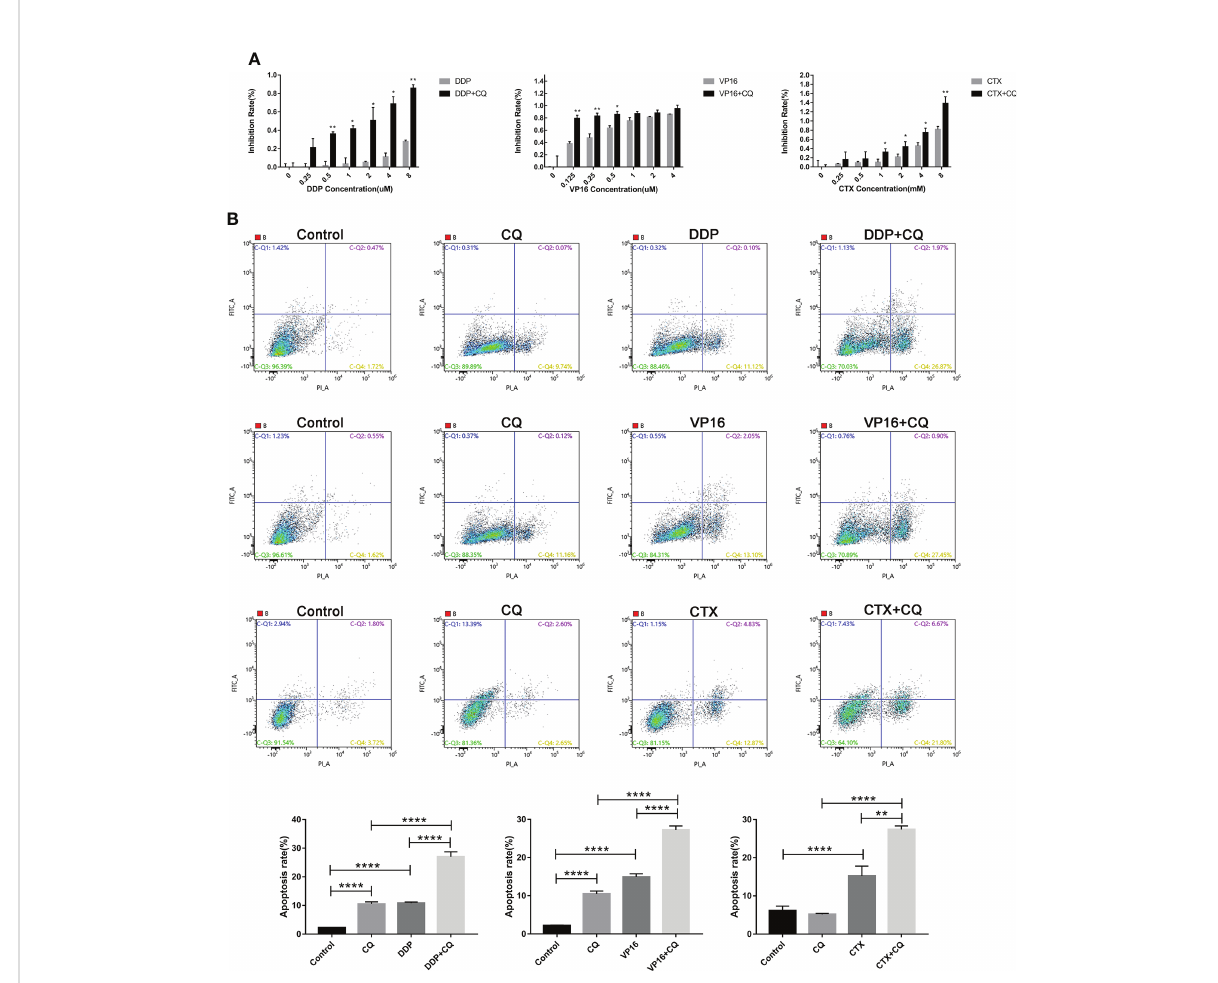
FIGURE 4 Inhibition of autophagy by CQ increases chemotherapy sensitivity and apoptosis. (A) CCK8 results showed that inhibition rate of SH-SY5Y cells exposed to CQ combined with chemotherapy agents was signi fi cantly higher than that of the group exposed only to chemotherapy agents, *P < 0.05, **P < 0.01. (B) Flow cytometry results showed that the apoptosis rate of SH-SY5Y cells exposed to CQ combined with chemotherapy agents, was signi fi cantly higher than that only exposed to chemotherapy agents. The data represent the mean ± SEM of three independent experiments. *P < 0.05, **P < 0.01, ****P < 0.0001, two-tailed t